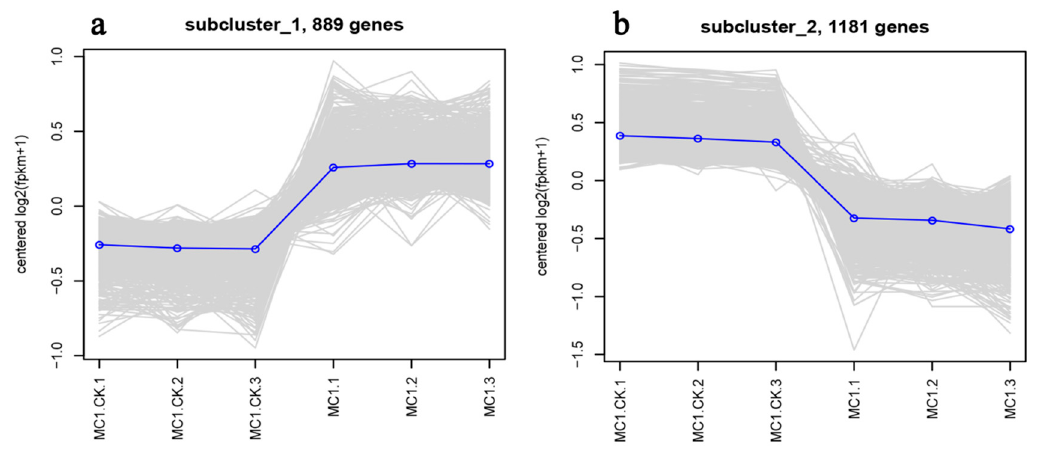
Figure 7. MC1 vs. MC1.CK differentially expressed genes sub-cluster trend lines. A total of 889 genes were analyzed by Branch 1 ( a ), and 1181 genes were analyzed by Branch 2 ( b ). The number of downregulated genes was higher than that of upregulated genes under high salinity.